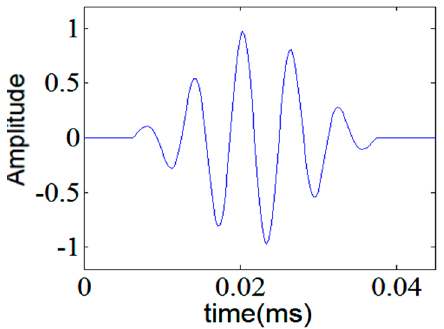
Figure 1. Hamming windowed, five-cycle tone-burst; tailored as a mother wavelet.